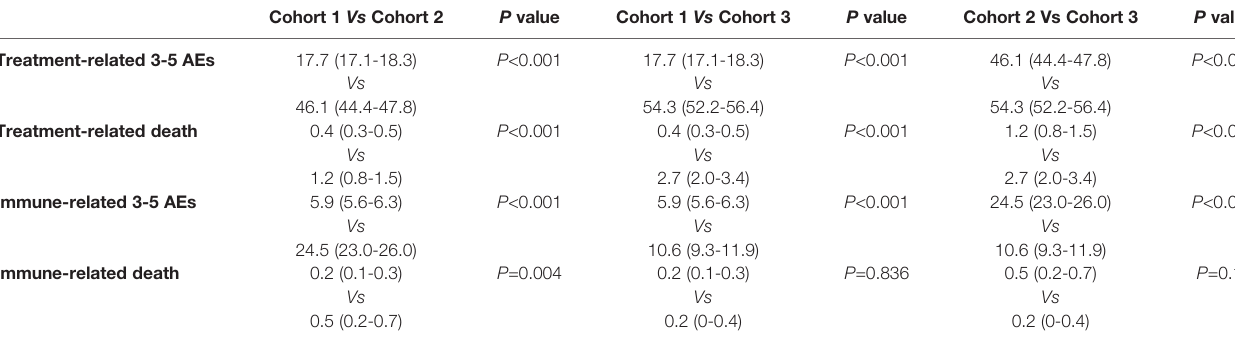
TABLE 2 | Comparison of grade ≥ 3 trAEs and irAEs from 3 cohorts.